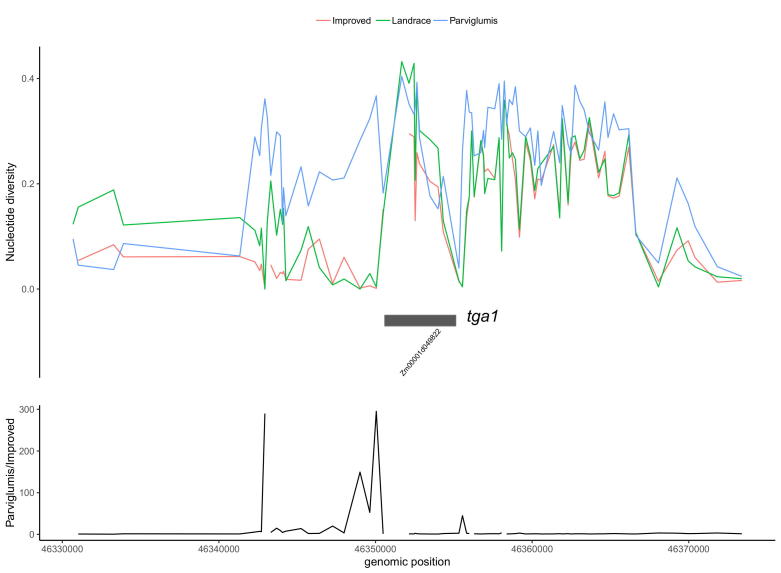
Nucleotide diversity analysis in the genomic region of tga1. The top panel shows the nucleotide diversity of different groups of maize lines. The bottom panel shows the division of nucleotide diversity of teosinte lines by that of the improved maize lines. Improved, improved maize lines. Landrace, maize landrace. Parviglumis, Z. mays ssp. parviglumis (teosinte lines).